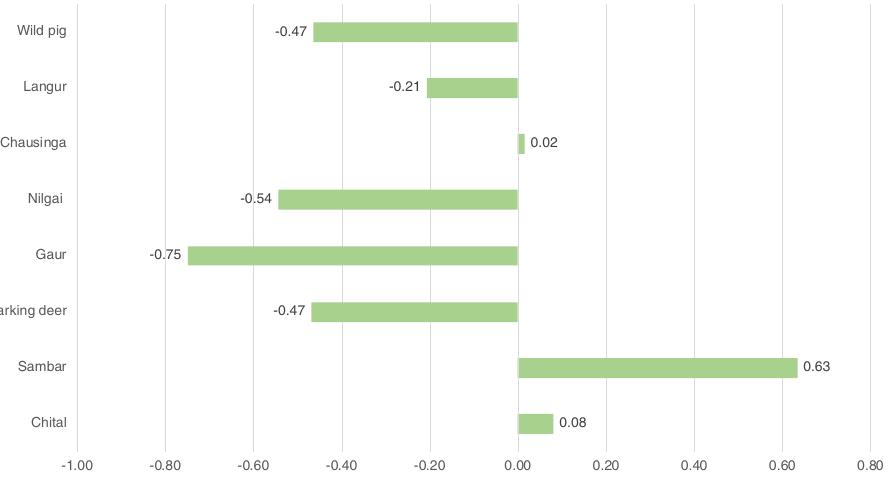
Figure 1. Jacobs’ index for prey preference in dhole diet across the central Indian landscape. The scale ranged from − 1 to + 1 representing strong avoidance and strong preference respectively. Sambar was the most preferred prey of dholes followed by chital and chausinga. Gaur, nilgai and wild pig were the least preferred